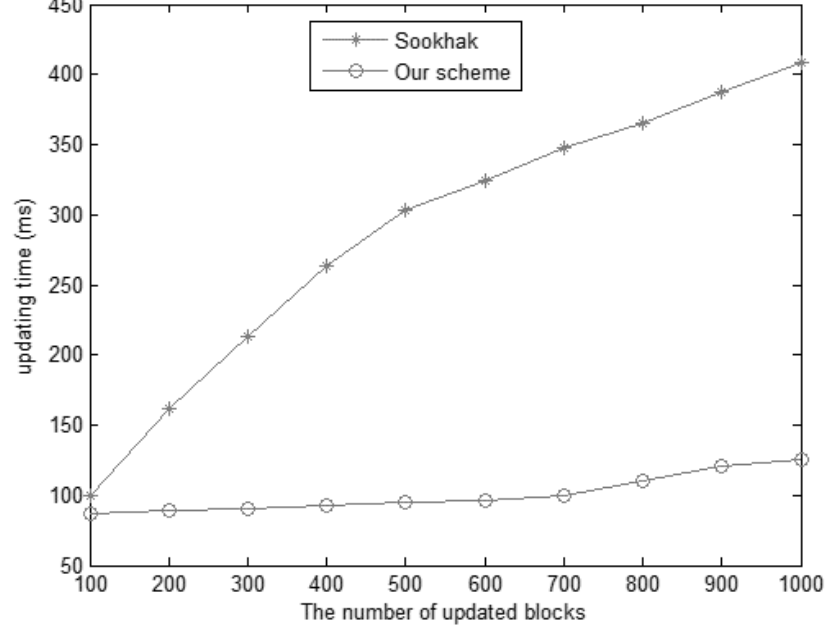
Figure 9. The updating time for different updated data